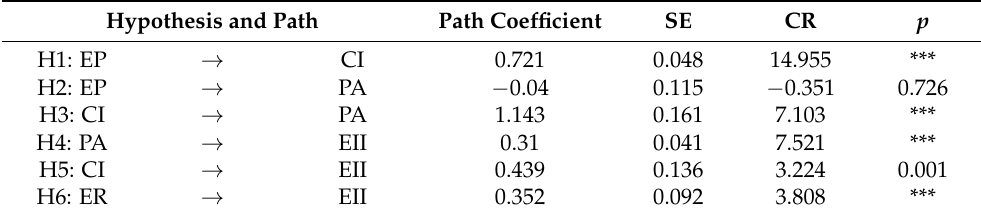
Table 3. Path analysis and hypothesis testing